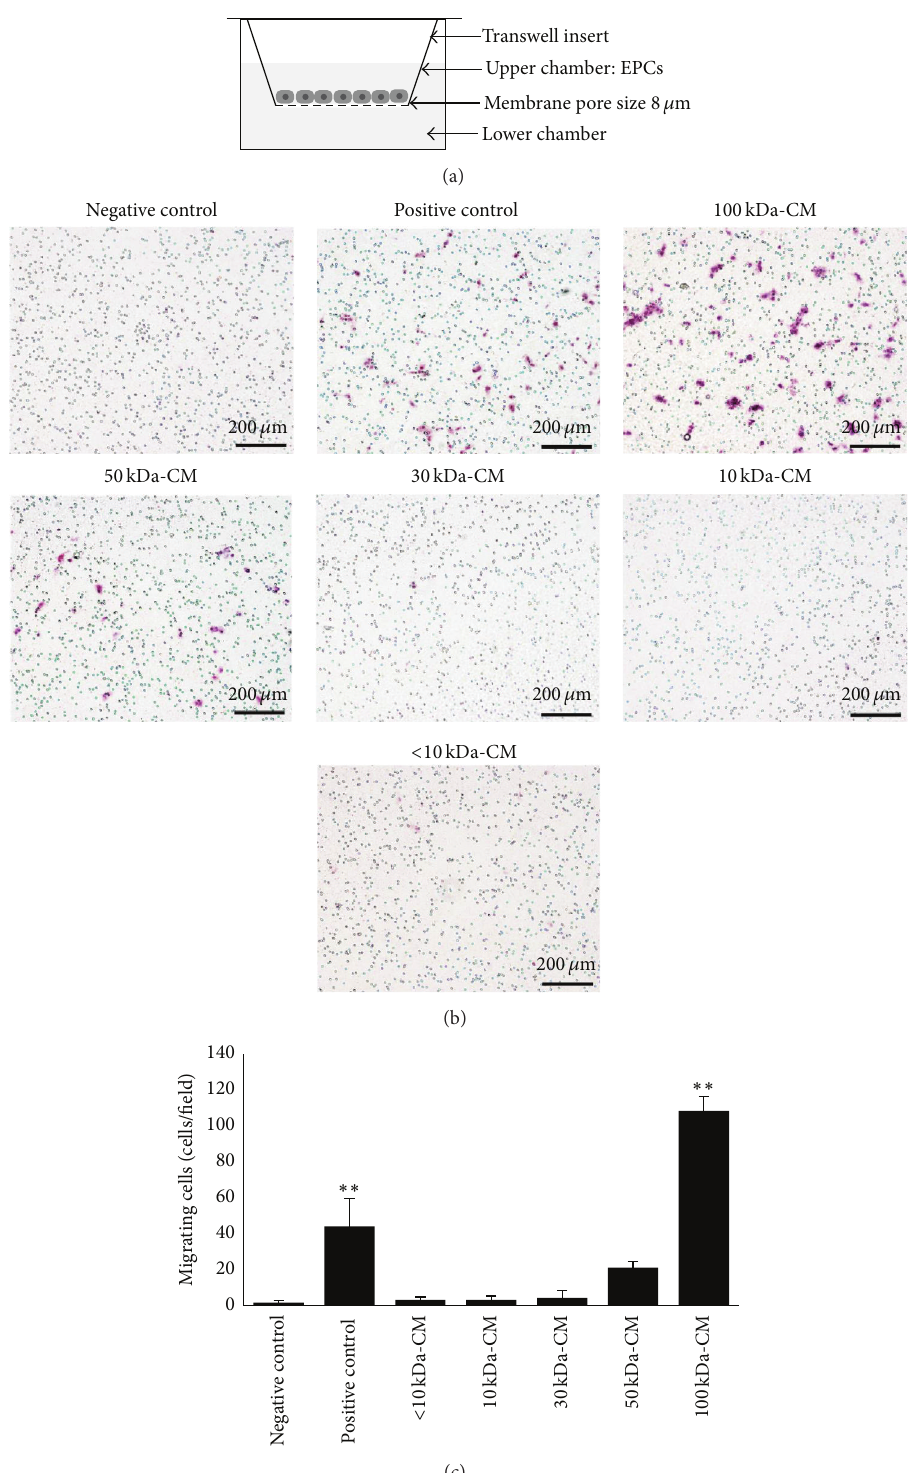
Figure 4: Effect of PL-MSCs conditioned medium fractions on EPC migration. (a) Diagram of the transwell culture system for an in vitro migration assay. (b) Hematoxylin stained EPCs which migrated to the other side of membrane in response to soluble factors presented in the 100kDa, 50 kDa, 30 kDa, 10 kDa, and less than 10kDa fractions of the PL-MSCs conditioned medium (scale bar = 200 𝜇 m). (c) Numbers of EPCs which migrated in response to soluble factors presented in the 100 kDa, 50 kDa, 30kDa, 10kDa, and less than 10kDa fractions of PL-MSCs conditioned medium. EPCs cultured in transwells whose lower chamber contained serum-free medium (SFM) served as negative controls while EPCs cultured in transwells whose lower chamber contained unfractionated PL-MSCs conditioned medium served as positive controls. Data were presented as mean ± SEM of three independent experiments. Nonparametric Kruskal-Wallis test was used to assess the significance of differences between observed data. ∗∗ 𝑃 < 0.01 versus negative